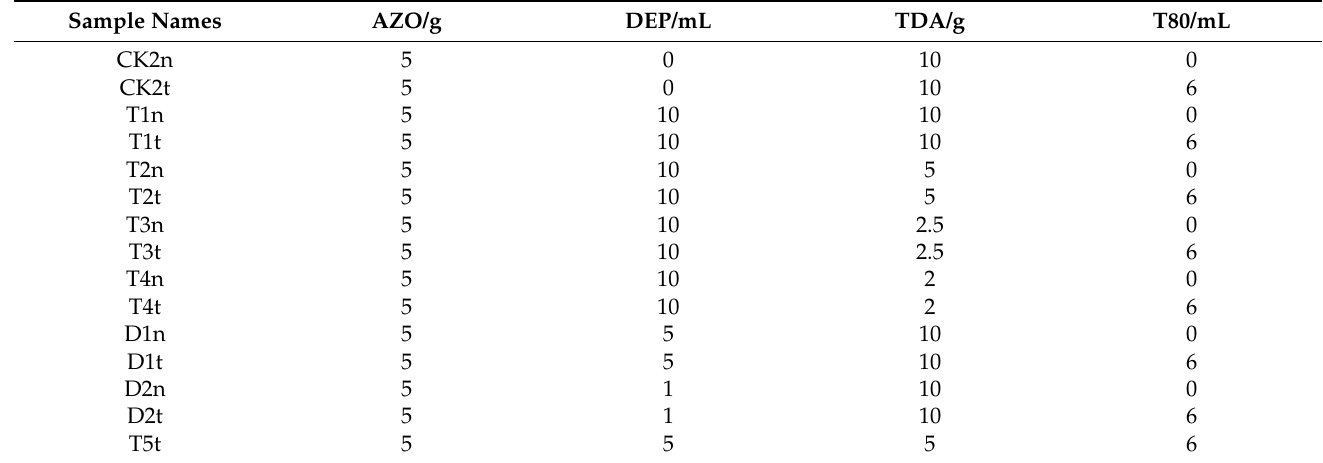
Table 2. Formula design for the screening of TDA and DEP additive amounts.